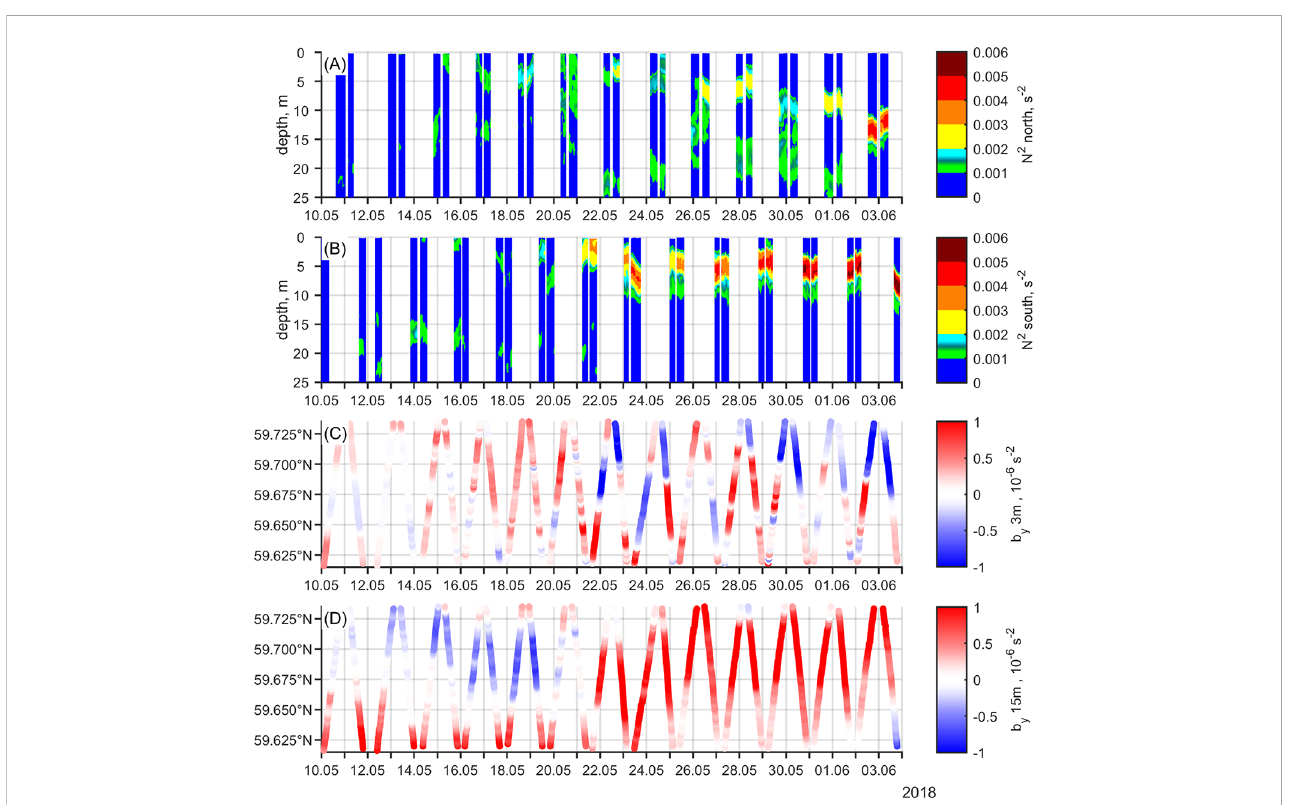
FIGURE 5 (A, B) Temporal changes in N 2 on the lighter and denser side of the mesoscale front in the upper 25 m, respectively. The lighter side is compatible with the position in the northern part of the glider transect (59.7242° N), and denser side with the position in the southern part (59.6252° N). Positions are 11 km apart. Note that one colored bar corresponds to about 1 km horizontal distance around the chosen position. To better illustrate the data, the distance correspondence in time is ampli fi ed about 5 times (bar width is increased). On average, the plotted distance was sampled in 1.4 ± 0.3 h. The movement of the glider between the southern and northern position can be deduced from subplots (B – D) that show along-transect horizontal buoyancy gradient as a function of time and latitude at 3, and 15 m depth, respectively. Positive gradient shows the increasing buoyancy along the sampled transect from S to